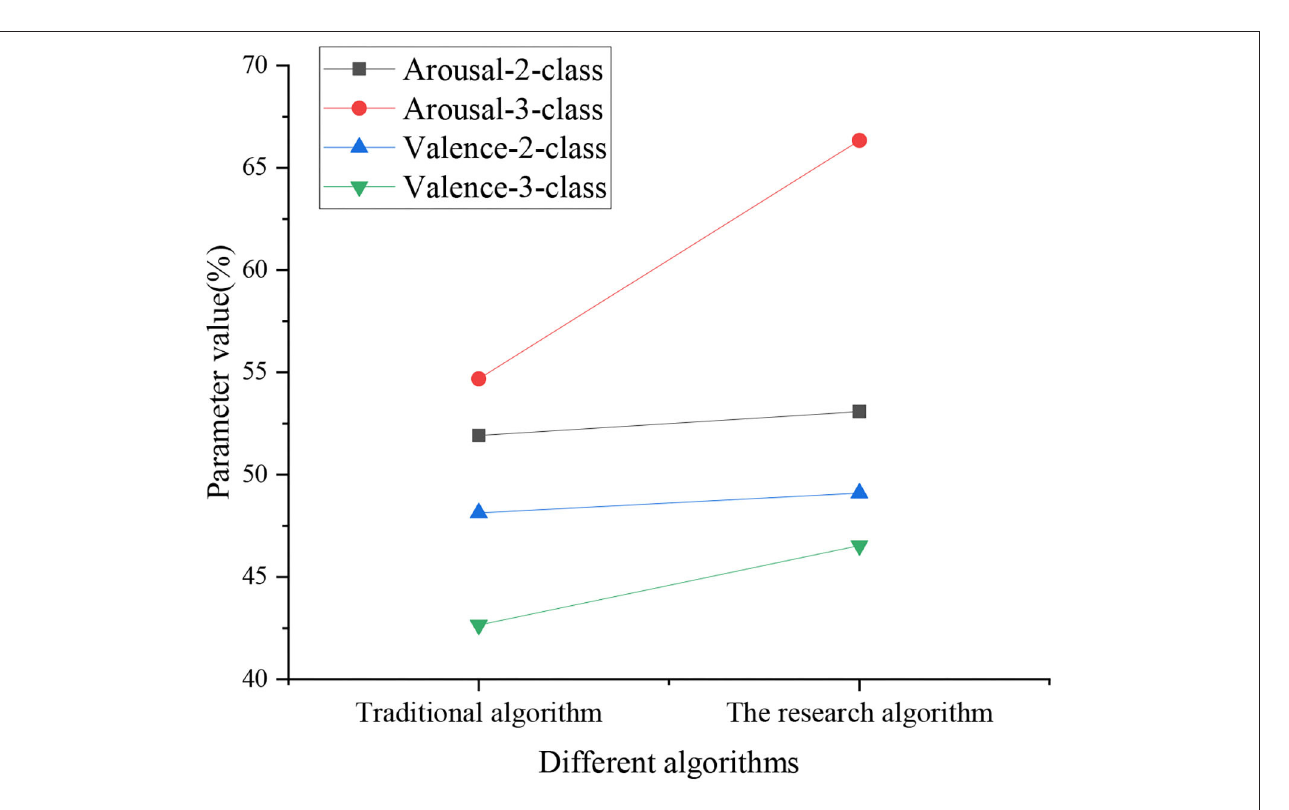
FIGURE 9 | Specific experimental results of different